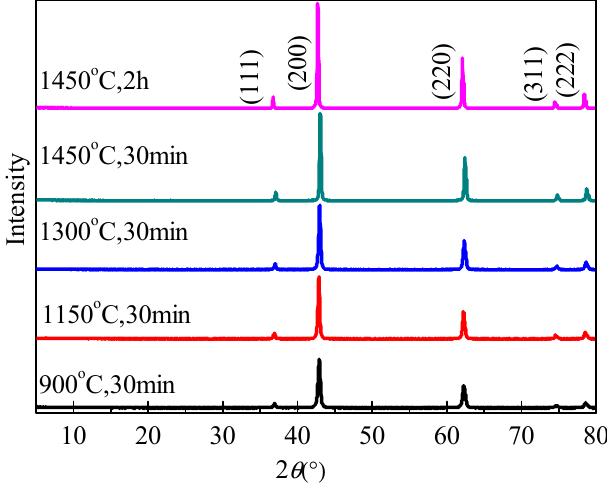
Figure 2. XRD patterns of MgO calcined under different temperatures and cooled in air. Table 2. Grain sizes of MgO calcined under different temperatures and cooled in air /nm.